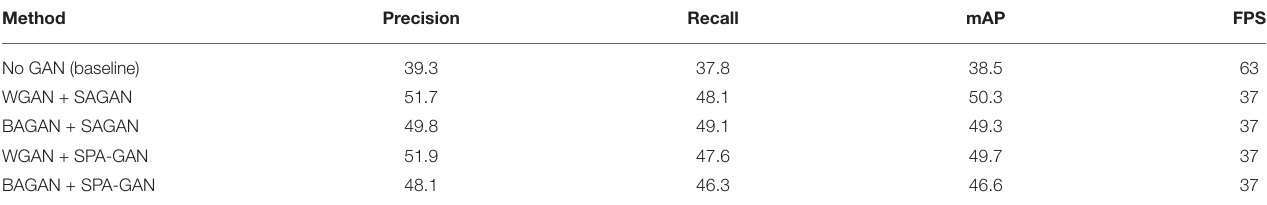
TABLE 2 | Results of different implements of GAN modules (in